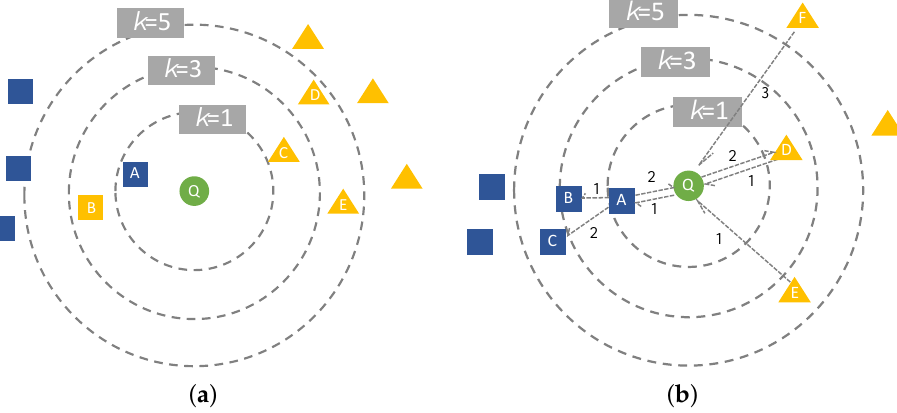
Figure 1. Illustration of the limitations of k NN. ( a ) k NN in data sets with label noise. ( b ) k NN in data sets with asymmetric proximity